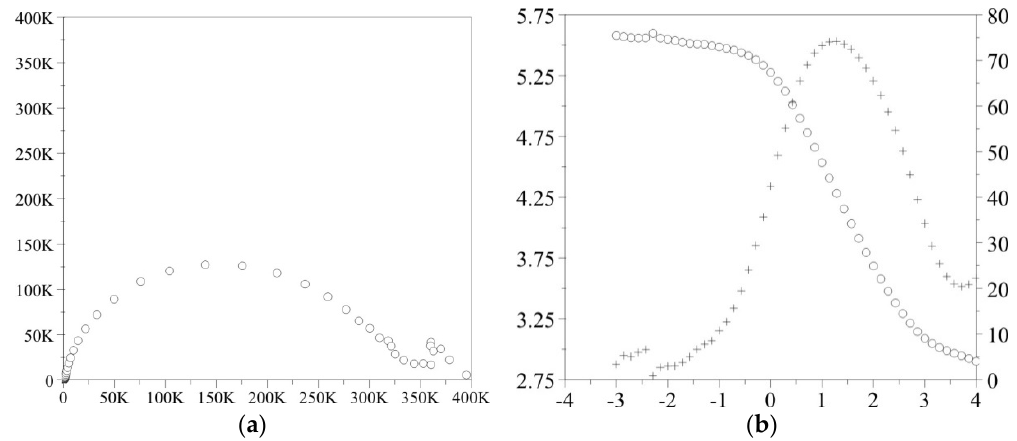
Figure 6. Impedance spectra determined for the samples with Atomic Layer Deposition (ALD) layer ( a ) Nyquist diagram, ( b ) Bode diagram. Table 5. Results of impedance tests for samples in the initial state and with ZrO 2 layer. Samples